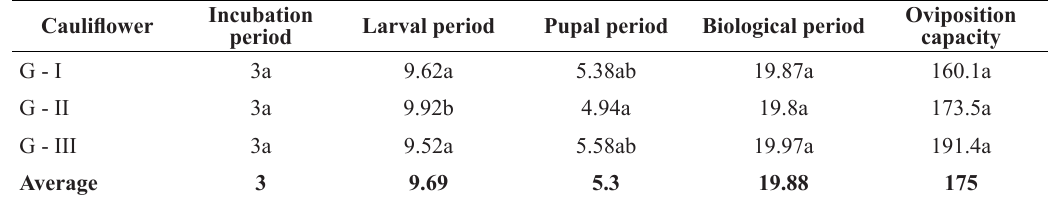
Table 2. Average of biological parameters of Plutella xylostella L., during three successive generations (G) in cau - liflower, under laboratory conditions. March - August 2013. La Molina, Lima - Peru.